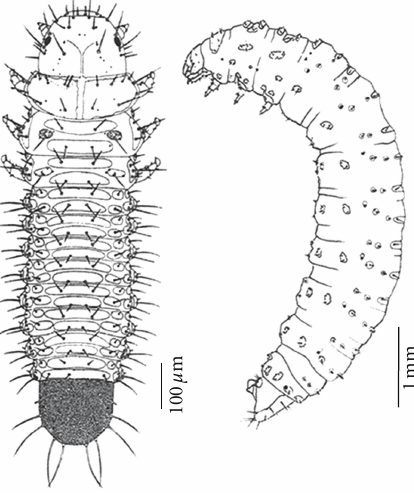
Figure 4: Neocrepidodera ferruginea , habitus of larva: (a) dorsal view; (b) lateral view. Modified from Blunck